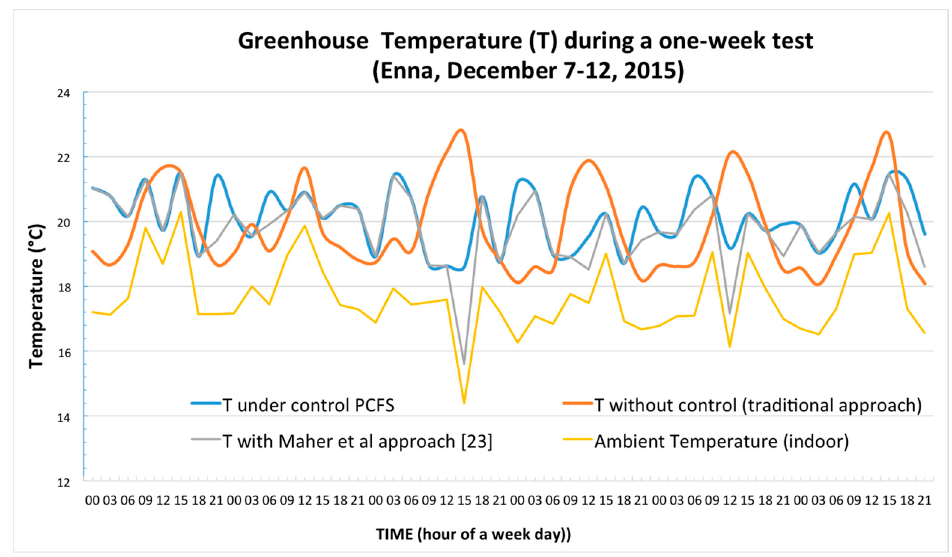
Figure 9. Greenhouse temperature (winter week).